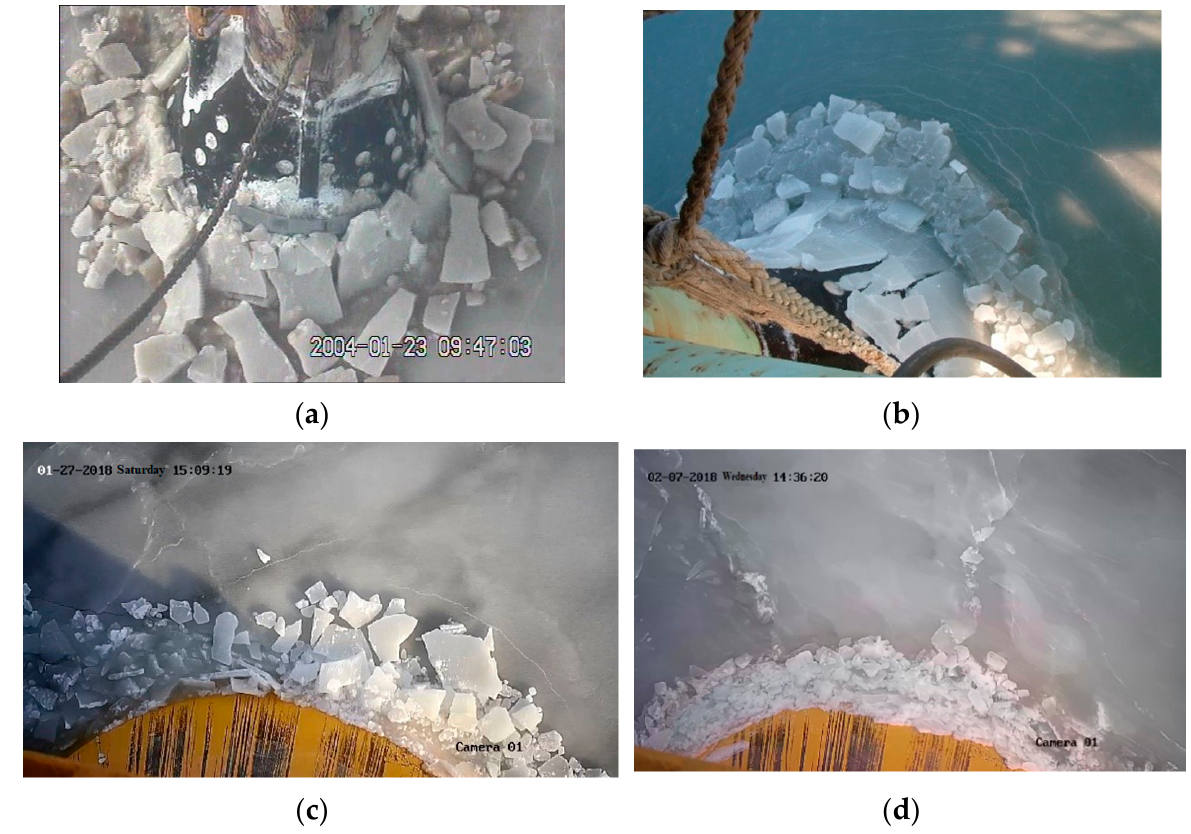
Figure 6. Sea ice bending failure on cones of different scales: ( a ) diameter-to-thickness ratio is 20; ( b ) diameter-to-thickness ratio is 45; ( c ) diameter-to-thickness ratio is 90; ( d ) diameter-to-thickness ratio is 180.